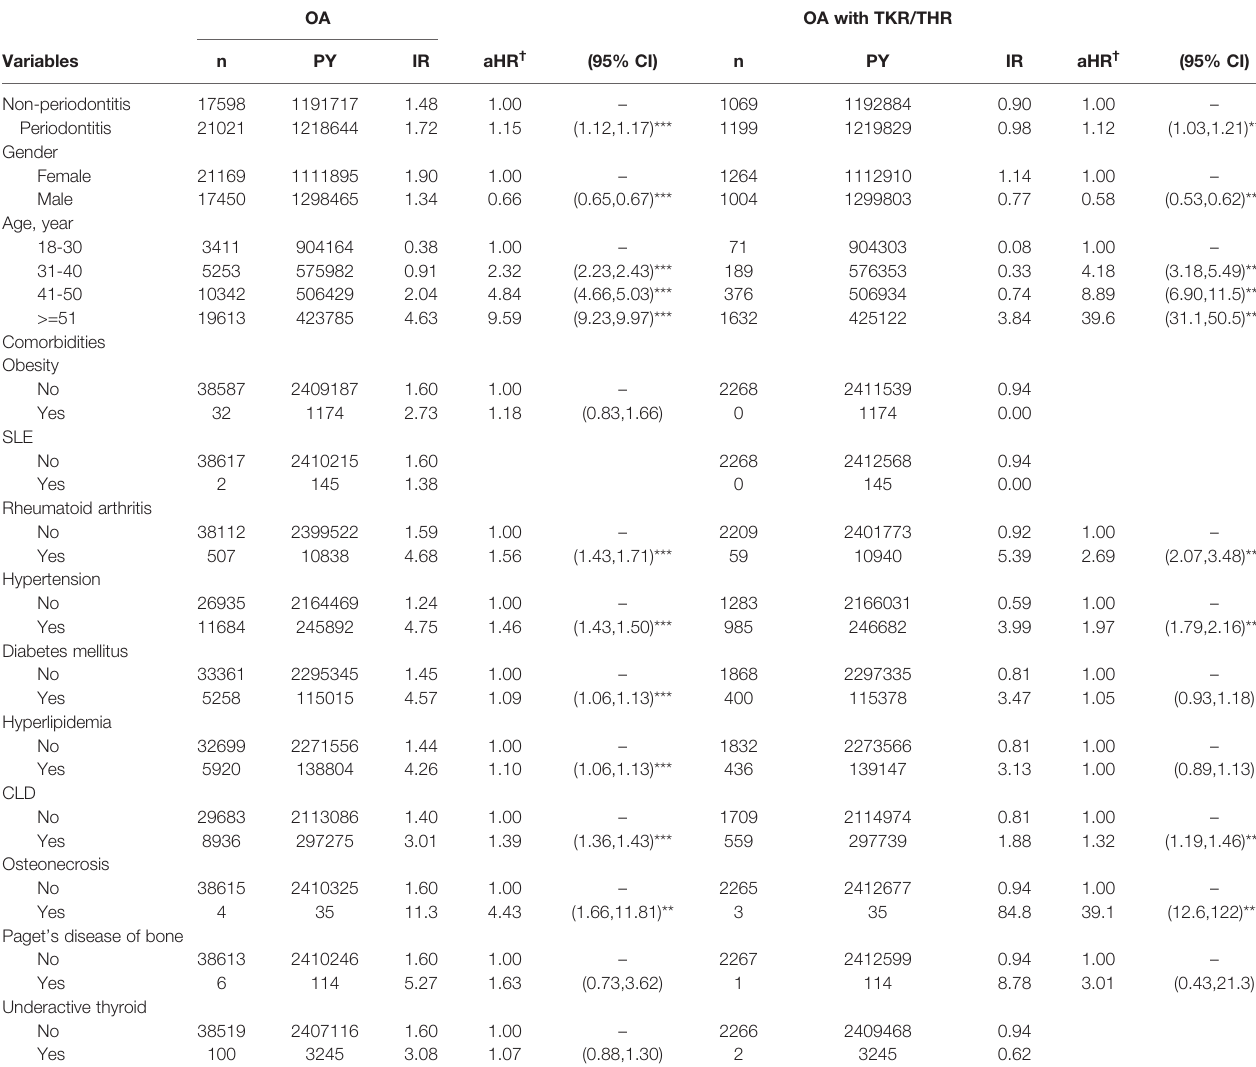
TABLE 2 | Multiple Cox proportional model for risks of osteoarthritis (OA) in the periodontitis cohort. OA OA with